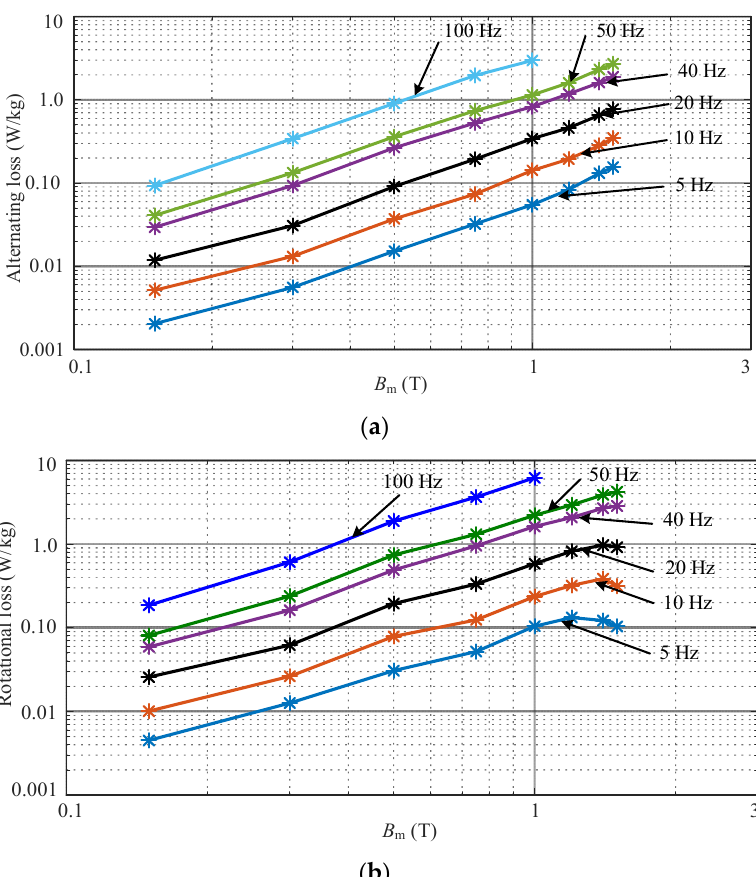
Figure 7. Measured core losses of an amorphous magnetic metal 1k101 sample under ( a ) alternating and ( b ) circularly rotating magnetic flux densities of different frequencies.